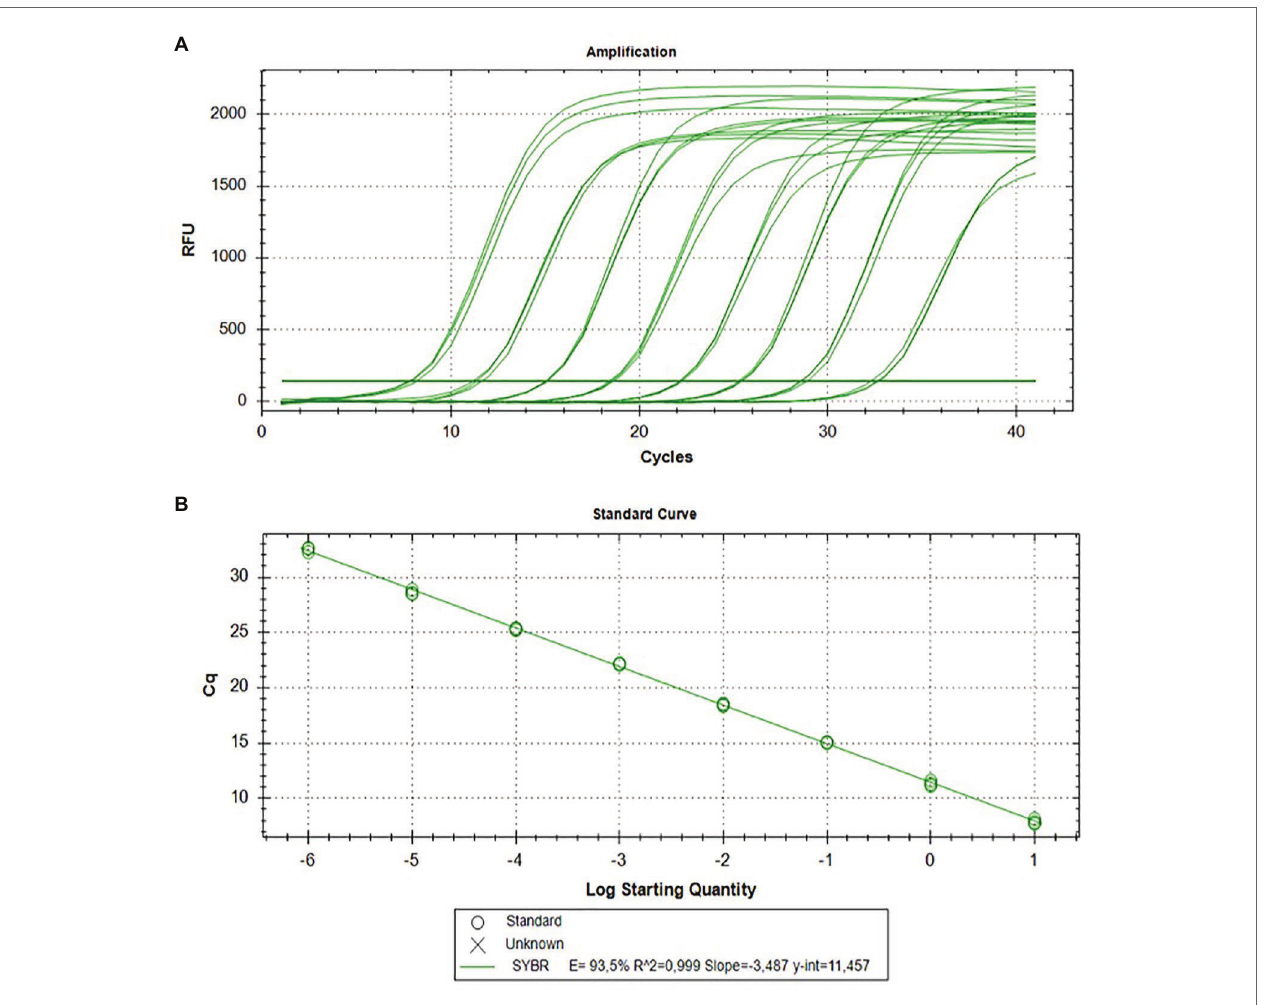
FIGURE 6 | Analytical sensitivity of the qPCR SybrGreen assay using the F3/B3 primer pair for ToBRFV detection. Amplification curves in triplicate (A) and the resulting standard curve (B) are